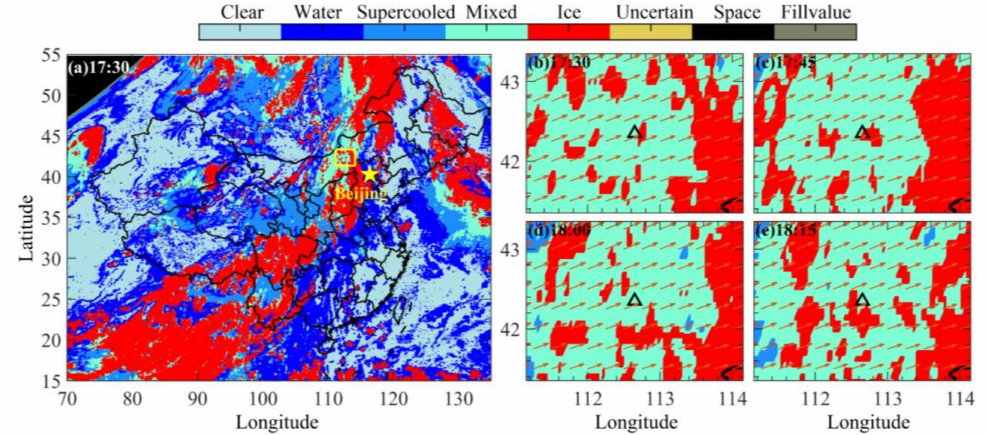
Figure 4. Cloud phase provided by FY4A satellite in 12 September 2019, local time. ( a ) shows the cloud phase across the China region at 5:30 p.m. local time, the yellow square indicates the seeding region. ( b – e ) show cloud phase distribution of seeding regions at different times. The black triangle indicates the location of the CDWL. The orange arrows and black triangle represent the wind vector and the location of the CDWL, respectively.